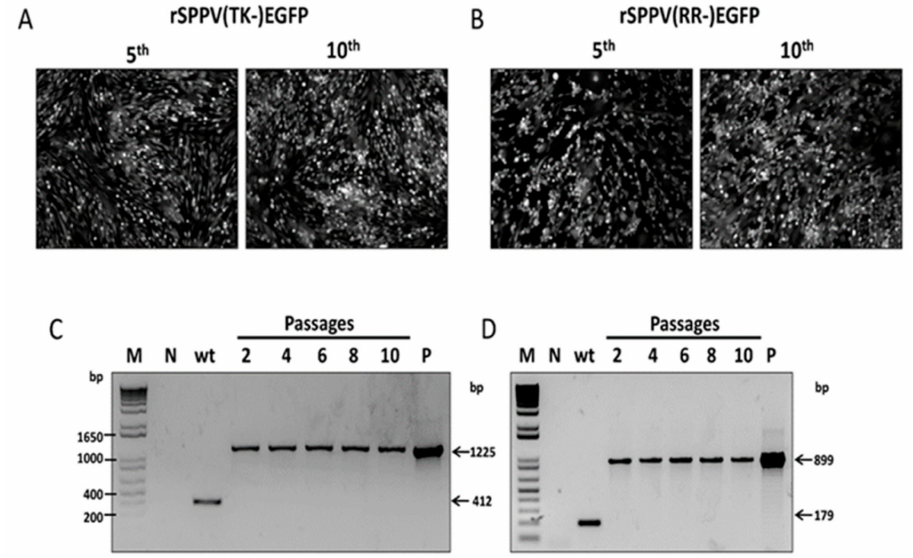
Figure 5. Analysis of genetic stability of the recombinant viruses by fluorescent microscopy ( A , B ) and PCR (C, D). ( A , B ) Expression of EGFP during passage was detected by fluorescent microscopy (10 × ). The TK or RR genes were amplified from the DNA of LT cells infected by rSPPV(TK-)EGFP ( C ) or rSPPV(RR-)EGFP ( D ), respectively, as templates after 10 passages. The DNA of LT cells infected with the SPPV NISKhI was used as negative control (wt) and pINT-TK-EGFP and pINT-RR-EGFP were used as positive control